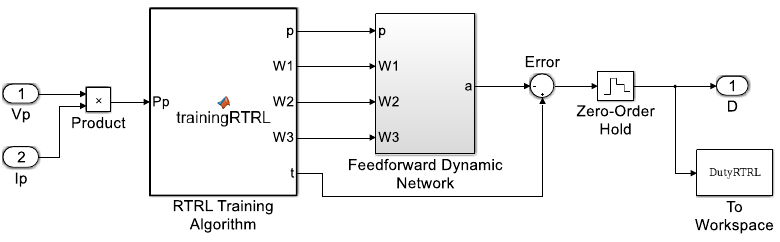
Figure 6. Block diagram of the RTRL Neurocontroller designed in MATLAB/Simulink.